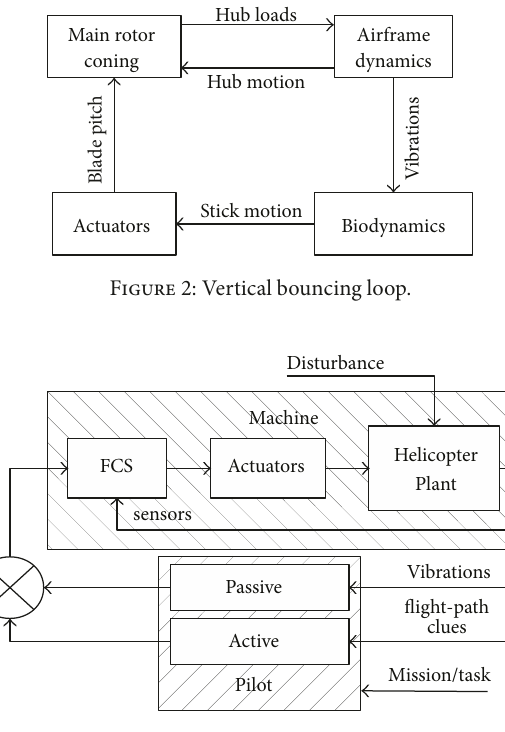
Figure 3: Pilot-in-the-loop